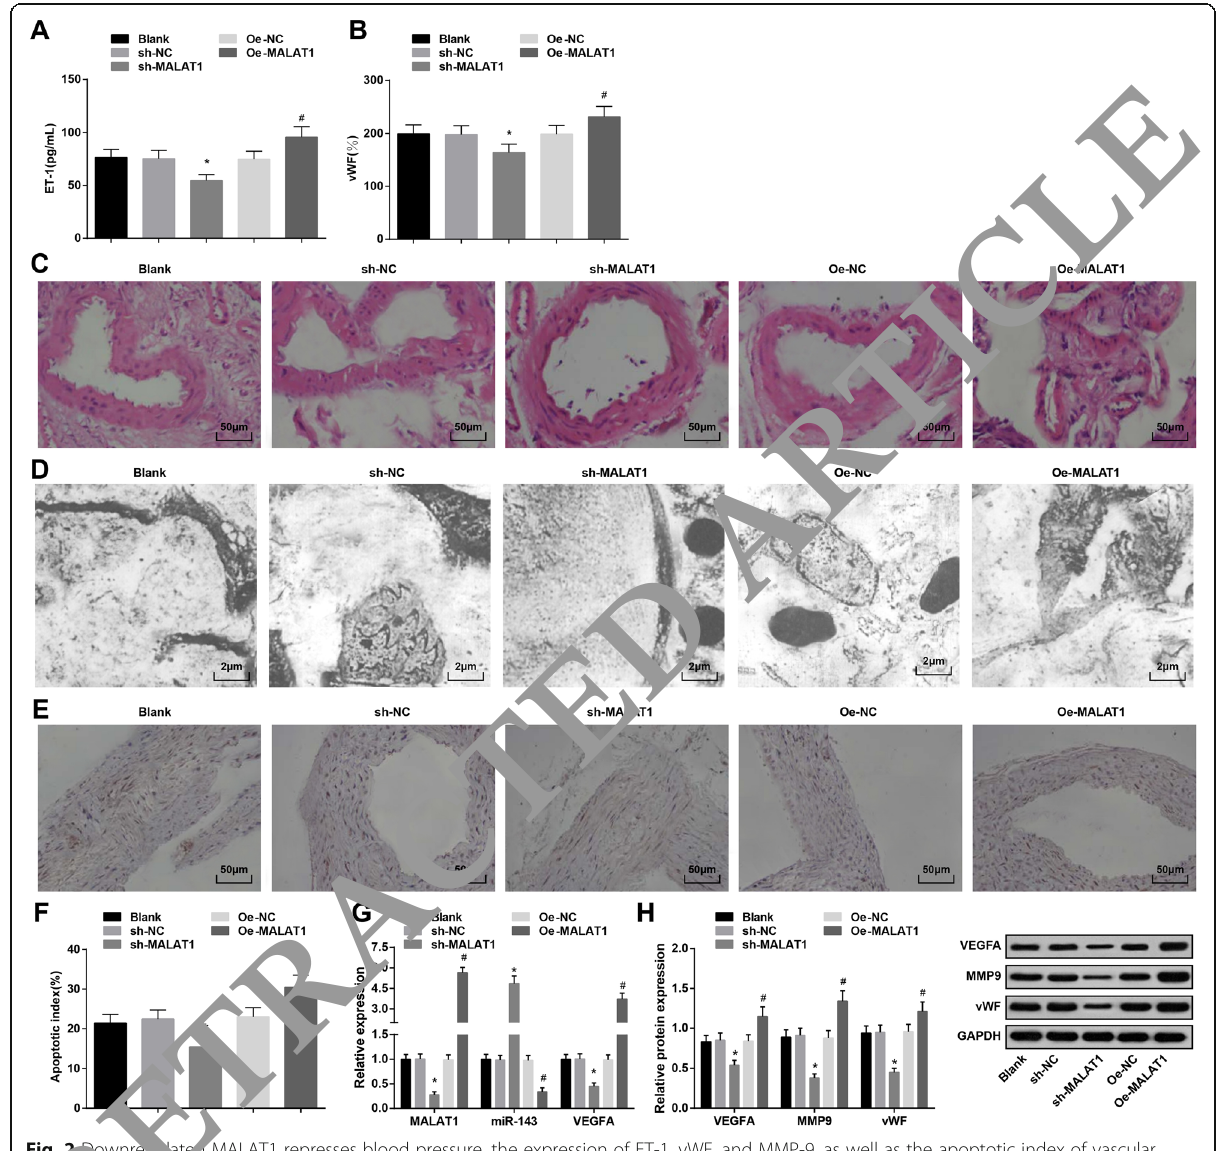
Fig. 2 Downregulated MALAT1 represses blood pressure, the expression of ET-1, vWF, and MMP-9, as well as the apoptotic index of vascular endothelial cells of rats with IA. a ET-1 expression in serum of rats by ELISA. b vWF expression in serum of rats by ELISA. c Pathological changes of IA tissues in rats observed by HE staining. d The ultrastructure of IA tissues in rats observed by a transmission electron microscope. e Apoptosis of vascular endothelial cells by TUNEL staining. f Vascular endothelial cell apoptotic index of rats. g MALAT1, miR-143, and VEGFA mRNA expression in IA tissues of rats by RT-qPCR. h VEGFA, MMP-9, and vWF protein expression in IA tissues of rats by western blot analysis. * P < 0.05 vs. the sh-NC group, # P < 0.05 vs. the Oe-NC group. Measurement data were depicted as mean ± standard deviation, and comparisons among multiple groups were assessed by one-way analysis of variance followed with Tukey ’ s multiple comparisons